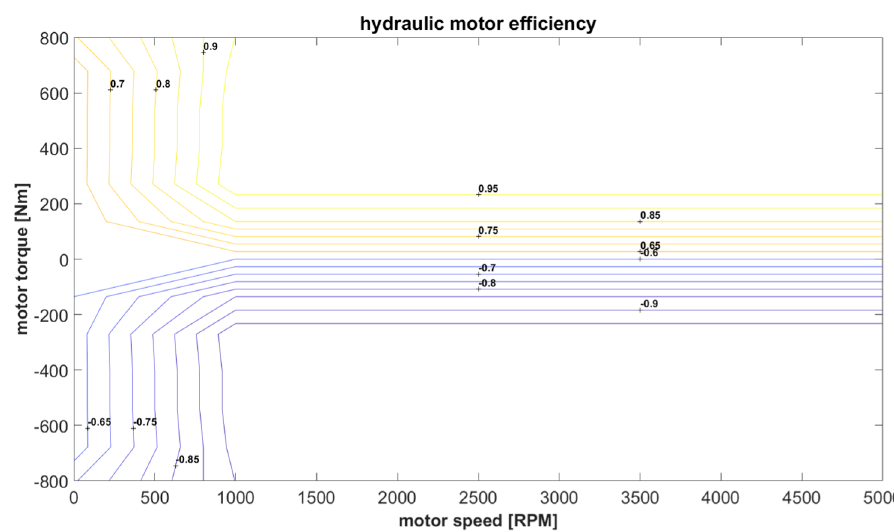
Figure 3. Efficiency of hydraulic motor/pump [1]. Figure 3. E ffi ciency of hydraulic motor / pump